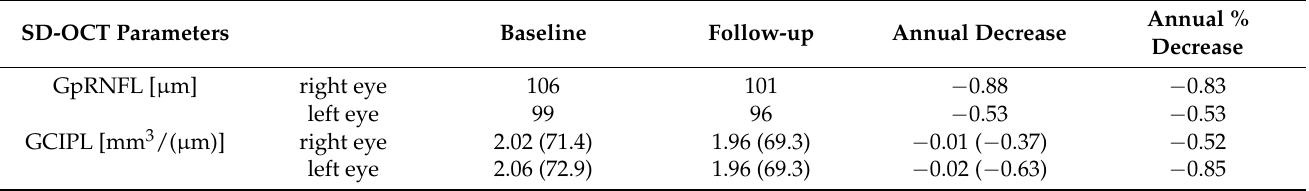
Table 3. Longitudinal single-case observation of change in optical coherence tomography